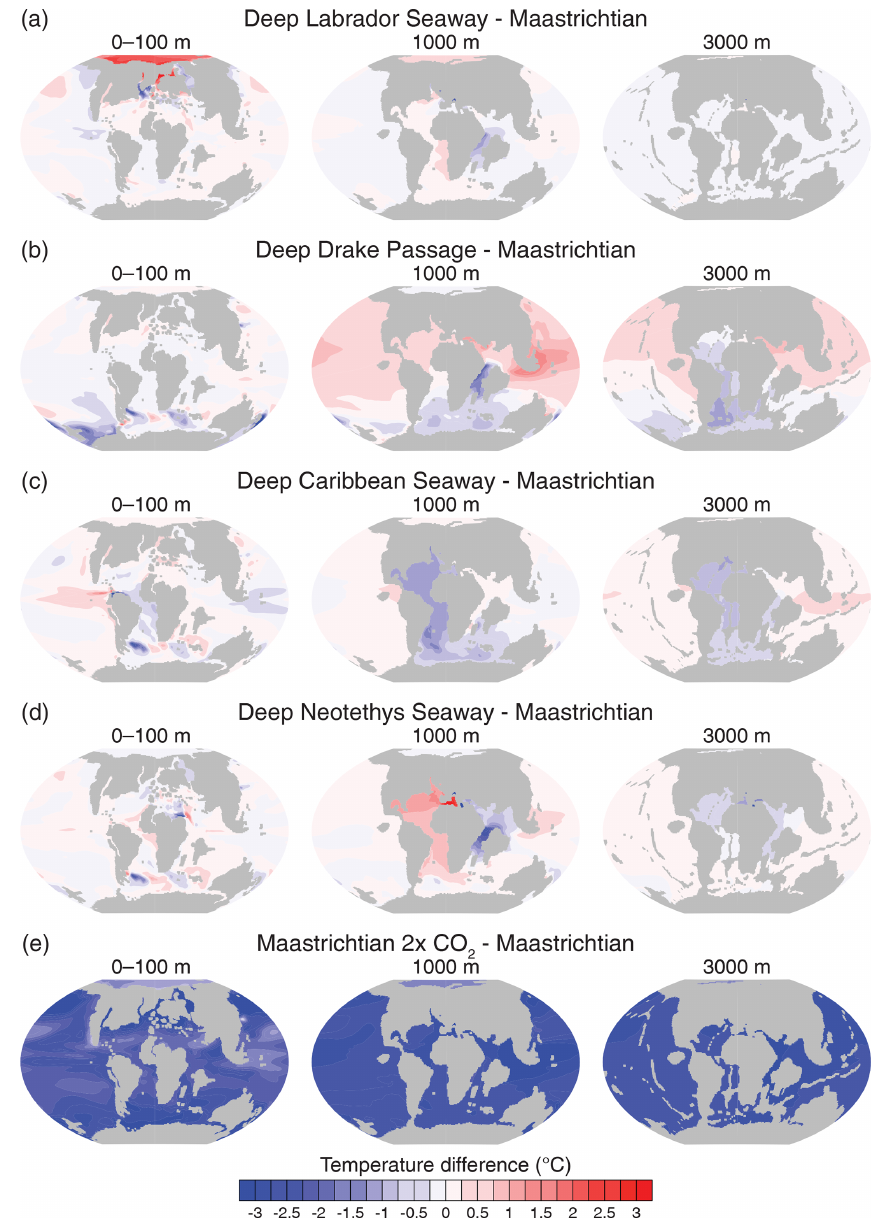
Figure 12. Surface, intermediate, and deep ocean temperature difference ( ◦ C) between the sensitivity experiments and the Maastrichtian